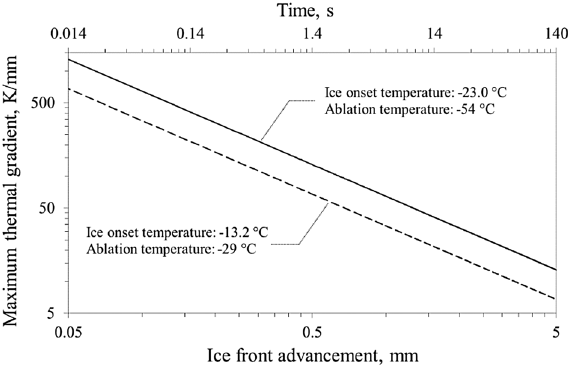
Figure 8. Maximum thermal gradient at the frozen–unfrozen tissue interface versus ice front advancement for different onset and ablation temperatures. The time scale regards the solid line trend and it must be about doubled for the dashed line (~ 0.028 ÷ 280